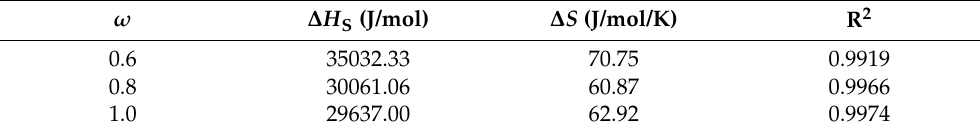
Figure 4. Solubility of PMBA at different ethanol mass fractions fitted by the Van’t Hoff equation. Table 1. The dissolution enthalpy and dissolution entropy of PMBA under different ethanol